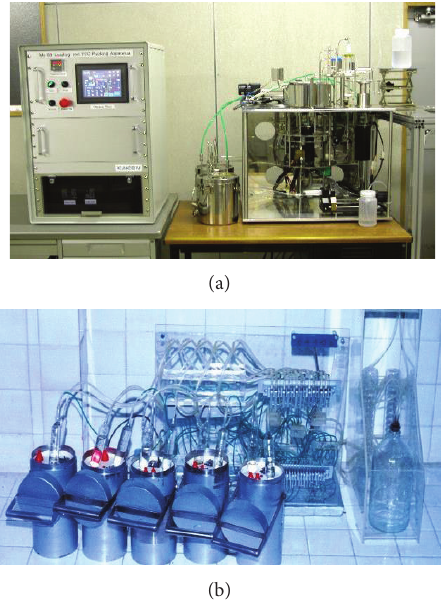
Figure 12: Loading of 99 Mo solution on the PZC/PTC sorbents for 99 m Tc-generator production: (a) automatic machine developed by Kaken Co. Ltd. (Japan) for the in-pot 99 Mo-adsorption on PZC sorbent followed by packing of 99 Mo-loaded PZC into the generator column in the process of PZC sorbent-based 99 m Tc- generator production [107]; (b) the 99 m Tc-generators installed with prepacked PZC/PTC sorbent columns are in-line loaded with low specific activity 99 Mo solution in the process of PZC/PTC-based 99 m Tc-generator production at NRI [108].